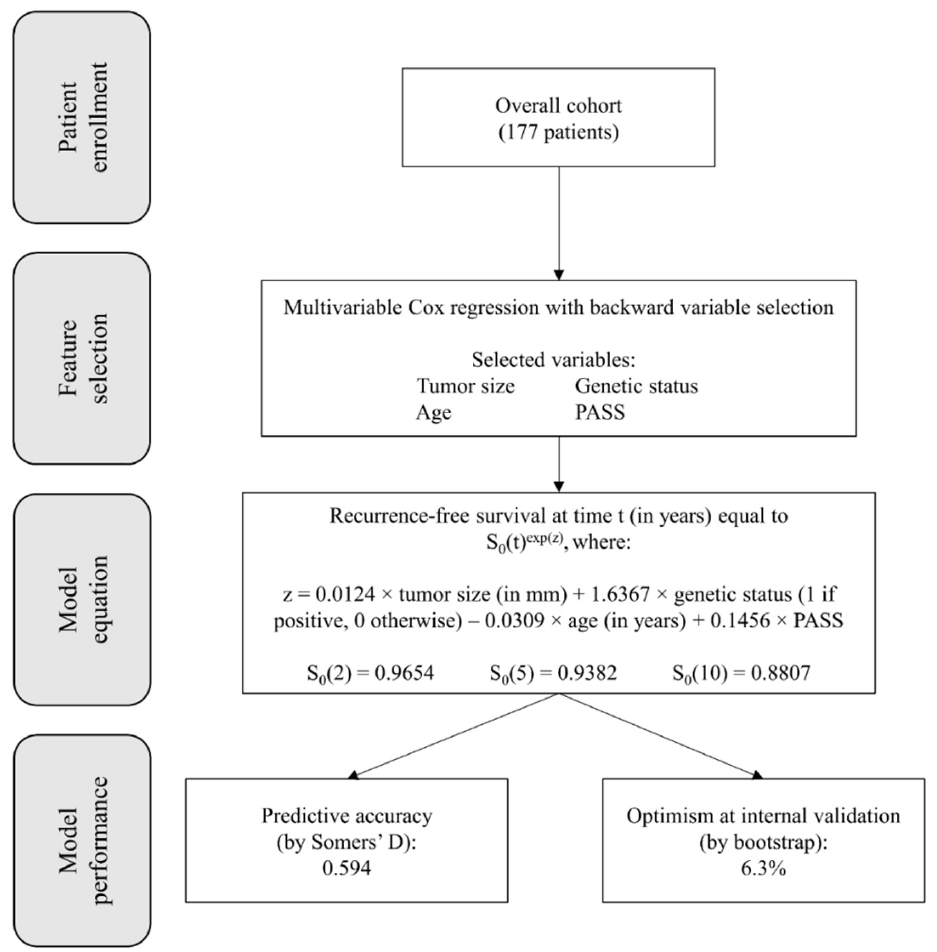
Figure 1. Graphical summary of the process adopted for the development and internal validation of SGAP-model in our previous article. Abbreviations: PASS, Pheochromocytoma of the Adrenal gland Scaled Score; SGAP, Size–Genetic–Age–PASS.